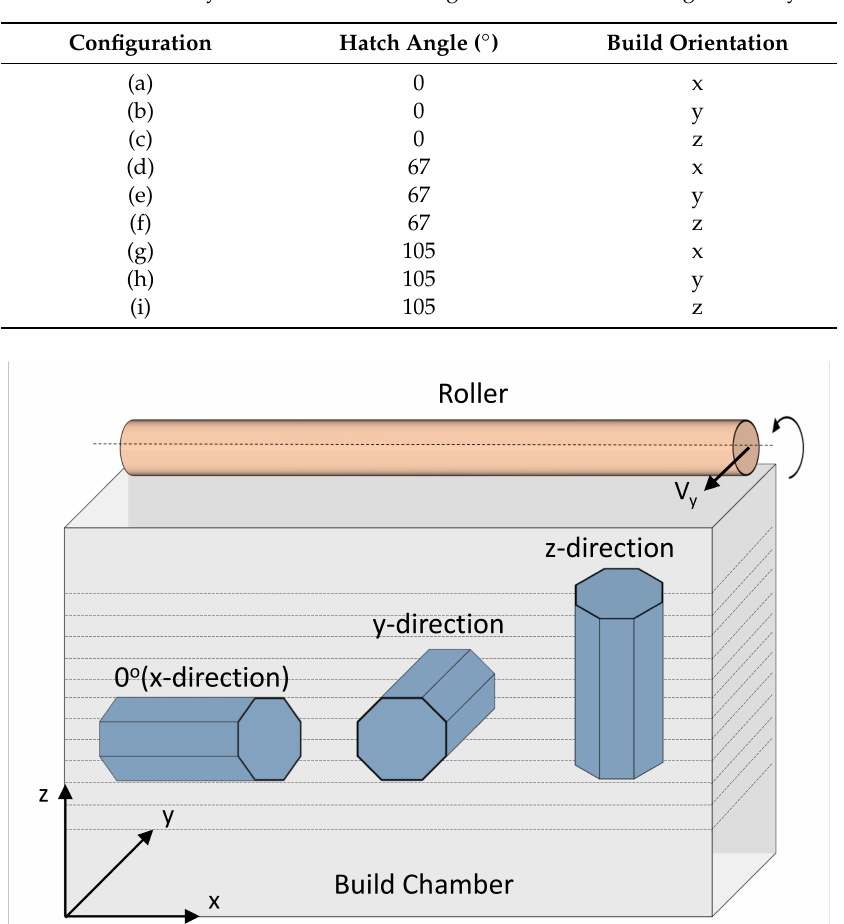
Figure 2. Schematic view of the scan direction in-between layers (configuration (f) in Table 3). Table 3. Summary of di ff erent build configurations studied during this study.